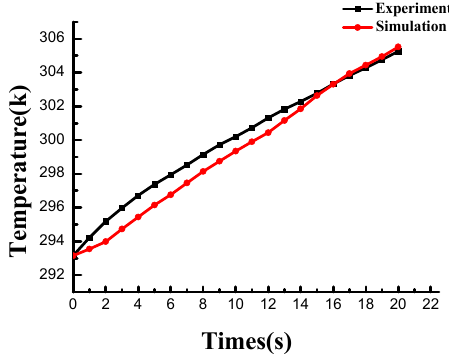
Figure 7. Simulation and experimental study on the temperature change of the upper surface center point.